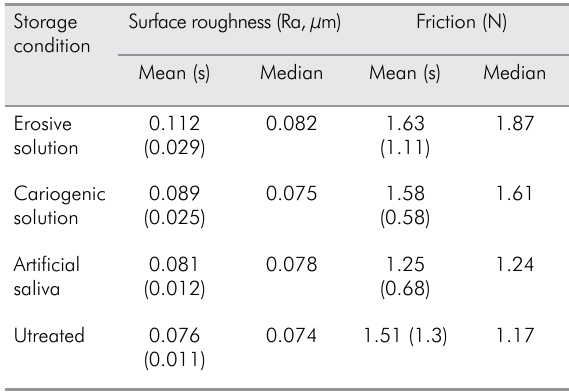
Table. Surface roughness and friction values for CuNiTi